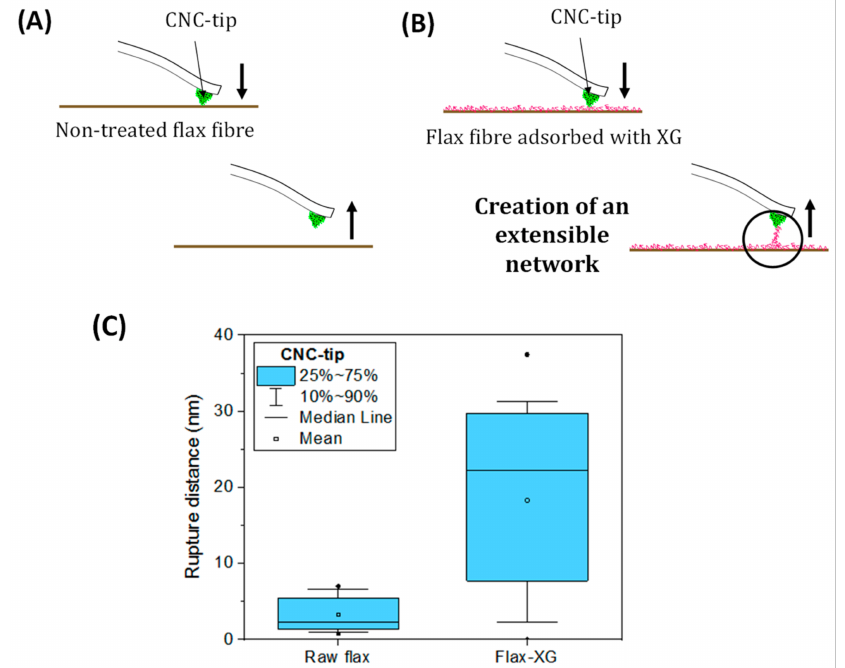
Figure 22. Illustration of the adhesive force measurements conducted by AFM with a CNC modified tip on two substrates: ( A ) non-treated flax fibres and ( B ) a XG modified flax fibre; and ( C ) mea- sured rupture distances between the CNC-tip and raw flax and XG-flax substrates (reprinted with permission from Doineau et al., 2020